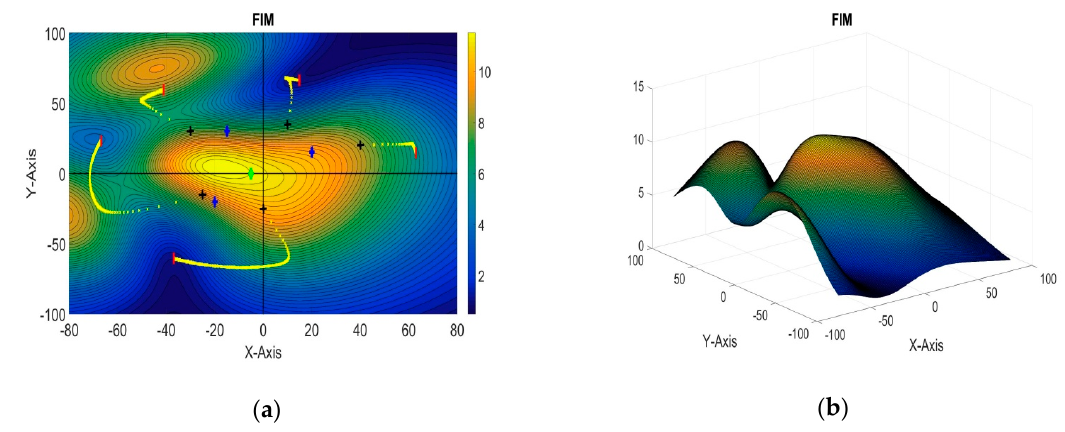
Figure 8. ( a ) 2D contour plot of the evaluation function (5 + 1 sensors, three targets); ( b ) 3D plot of the evaluation function (5 + 1 sensors, three targets). evaluation function (5 + 1 sensors, three Table 4. Optimal Positions of Sensor AUVs (Various Sensor–Target Configurations).